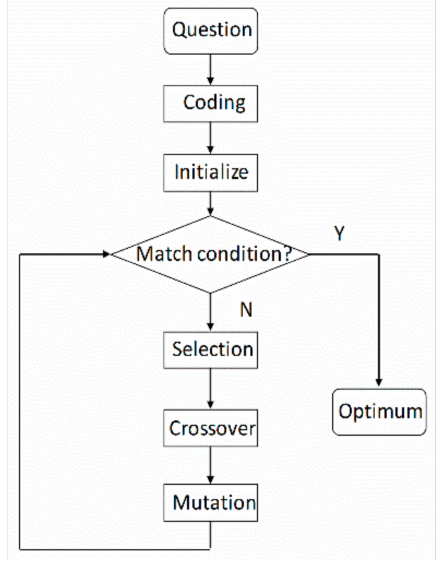
Figure 4. Genetic function approximation